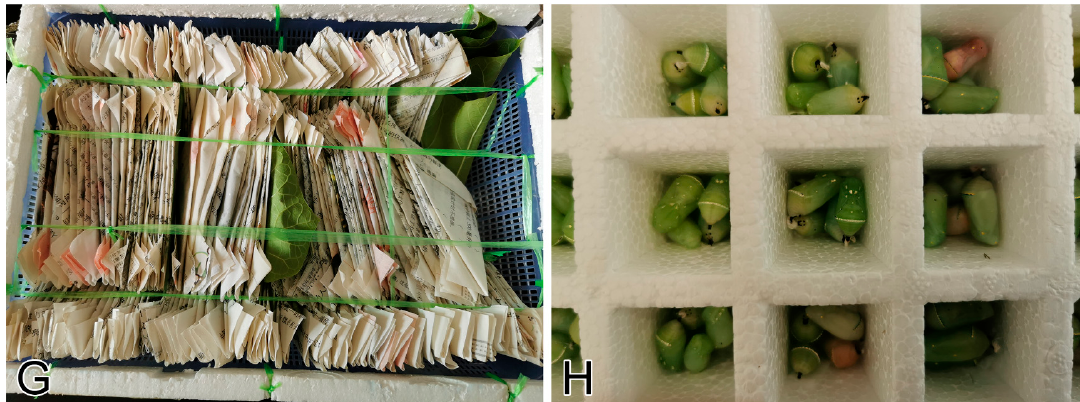
Figure 3. Butterfly ranches in China. ( A ): Ranch greenhouse in Yunnan; ( B ): Ranch garden in Hainan; ( C ): Local women employed in the Yunnan butterfly ranch; ( D ): Ranchers in Yunnan explain butterfly life cycles to the public; ( E ): Larvae of reared Cethosia cyane (Heliconiinae); ( F ): Adults of reared Tirumala limniace (Danainae); ( G ): Packed live adults ready for shipping; ( H ): Packed live pupae (Danainae) ready for